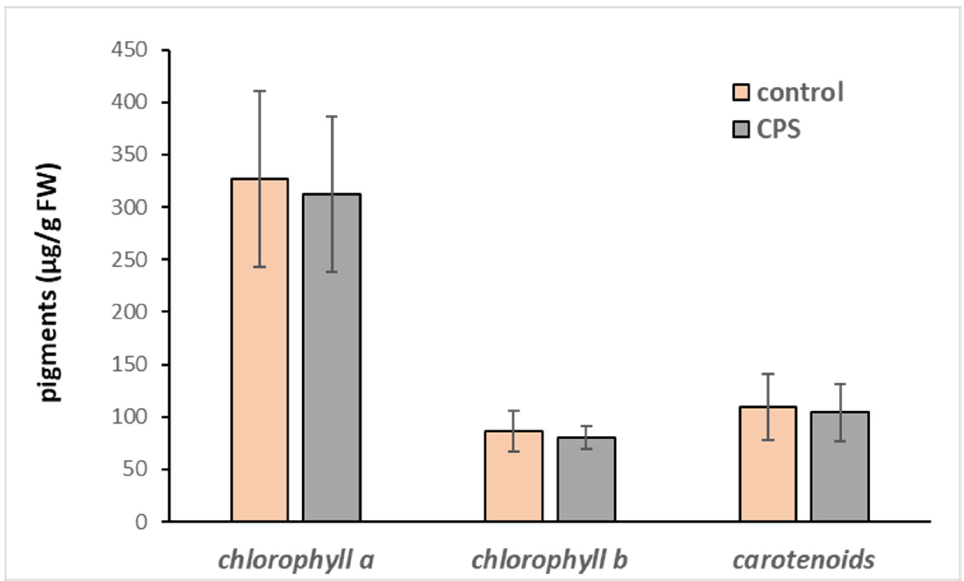
Figure 3. Chlorophyll a , chlorophyll b, and carotenoid content in hybrid aspen growing in medium supplemented with CPS at an initial concentration of 1 mg L − 1 . Samples were collected after 7 days of cultivation. The data represent the mean ± S.D. ( n = 4). The statistical analysis did not show any significant difference ( p < 0.05).